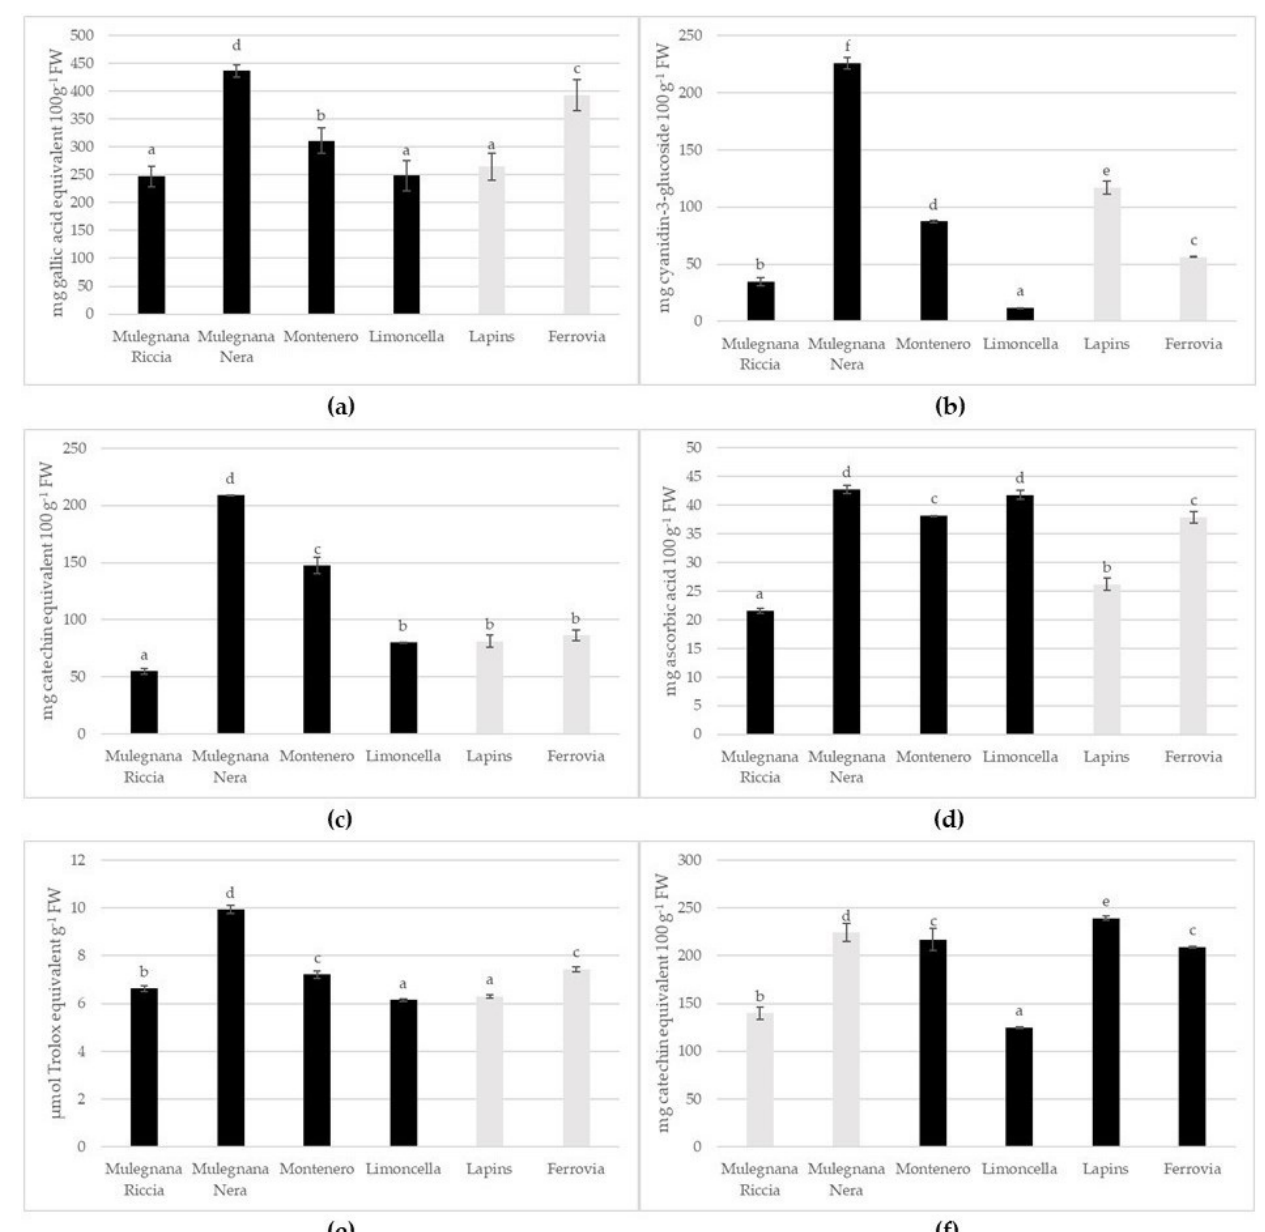
Figure 4. Total polyphenols ( a ), anthocyanins ( b ), flavonoids ( c ), ascorbic acid ( d ), antioxidant activity ( e ) and condensed tannin ( f ) in the four sweet cherry accessions (Mulegnana Riccia, Mulegnana Nera, Montenero and Limoncella) compared to two standard cultivars (Lapins and Ferrovia). Data represent means ± SD. The same letters indicate non-significant differences (Tukey test) between accessions/cultivars.